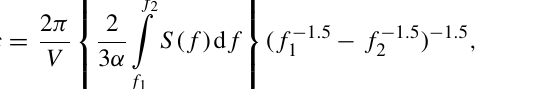
Figure 1. (a) For 28 March 2020, a joint probability density func- tion (PDF) of KAZR reflectivity and Doppler velocity in the vertical profiles with a liquid water path (LWP) value less than 0.25kgm − 2 and box-and-whisker plots showing the median Doppler velocity in every 1.5dB reflectivity bin. (b) For all 13 COMBLE cases, a joint PDF of KAZR reflectivity and Doppler velocity in the vertical pro- files with a LWP value less than 0.25kgm − 2 , the relative frequency distribution of KAZR Doppler velocity in the same low LWP peri- ods, and the relative frequency distribution of KAZR reflectivity in the same low LWP periods. Prepared using Crameri